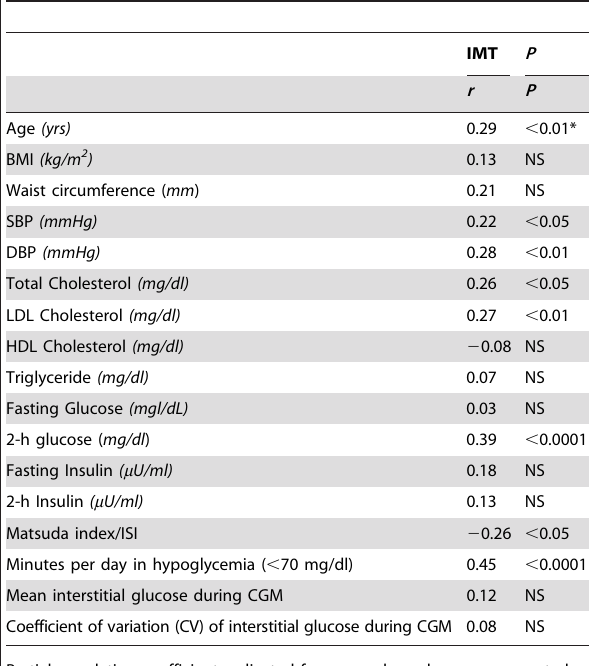
Table 2. Univariate correlations between IMT and anthropometric and biochemical